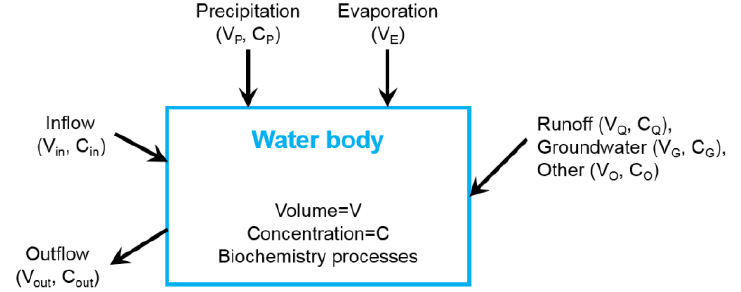
Figure 2. Generalized box diagram illustrating the budget for water and